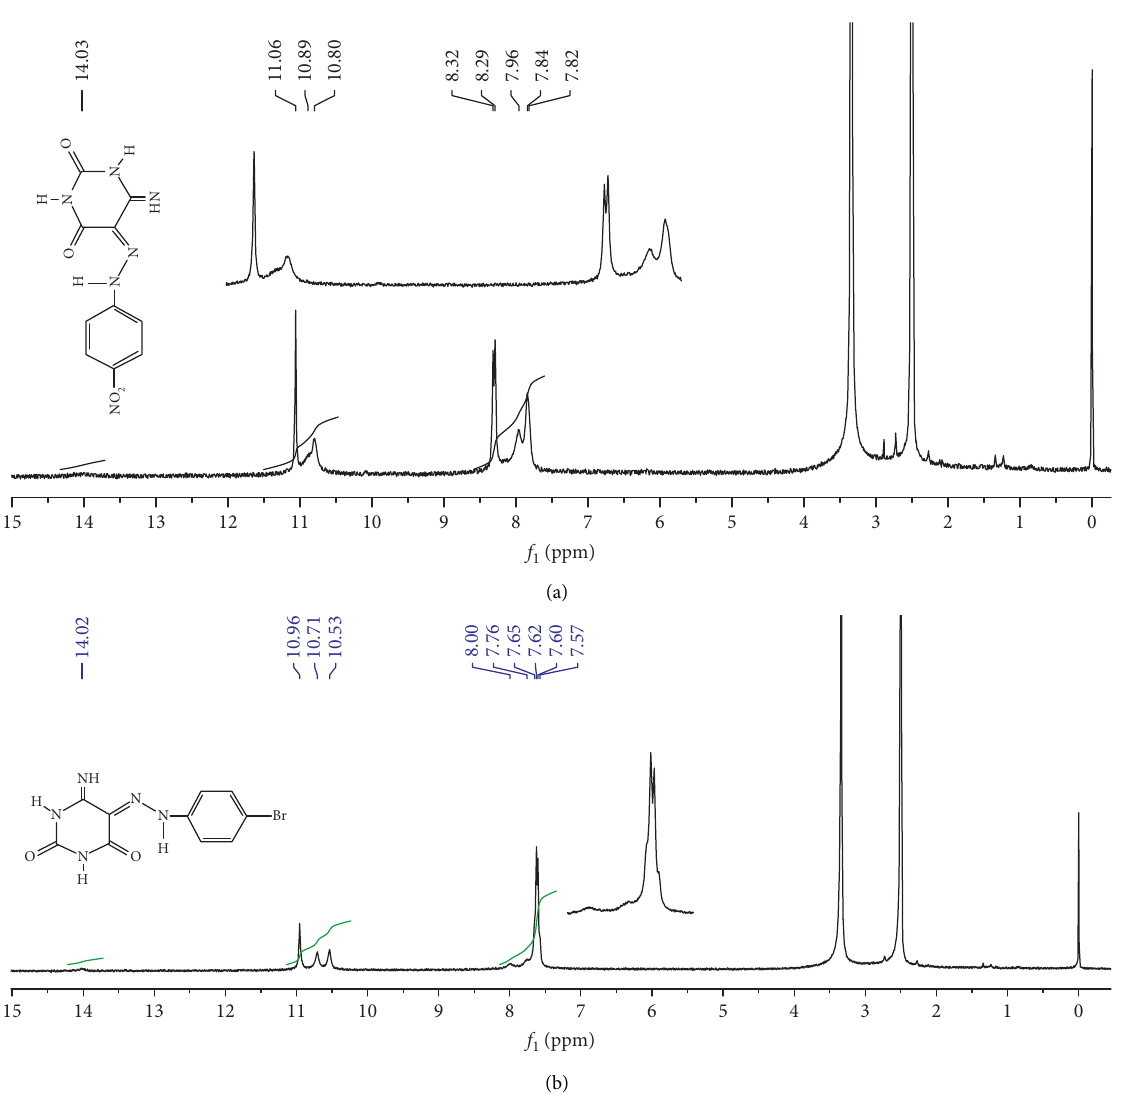
Table 3: 1 H isotropic chemical shifts of dyes I and II: experimental in DMSO- d